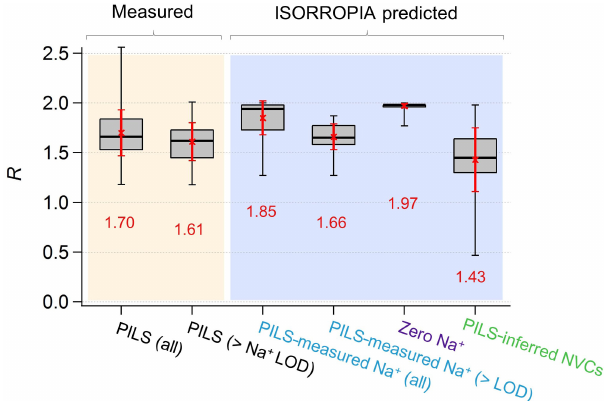
Figure 3. Comparisons of PM 2 . 5 ammonium-sulfate molar ratios ( R ) between measurements and ISORROPIA predictions for the base case but with differing Na + inputs. Data are from the SOAS study. Red numbers are the means and red error bars are 1 SD. Stan- dard box–whisker plots are shown, with 100% and 0% data indi- cated by black error bars. The top and bottom of the box are the interquartile ranges (75% and 25%) centered around the median value (50%). Comparisons include all data and periods when mea- sured Na + > LOD of 0.07µgm − 3